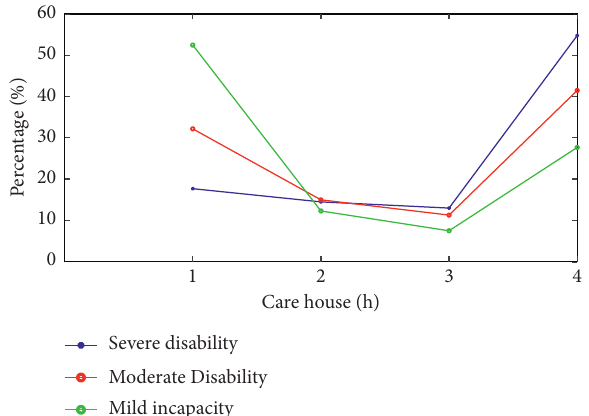
Figure 2: Differences in sources of emotional support for older people with different levels of disability at home.